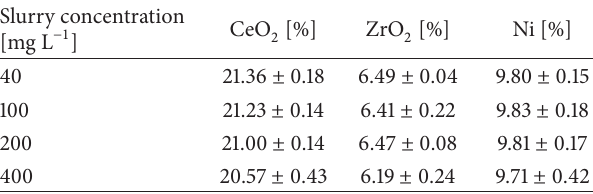
Table 2: Effect of slurry concentration on concentration of cerium, zirconium (calculated to metal oxide concentration), and nickel determined in Ni-CeZrO 2 /CNT hybrid